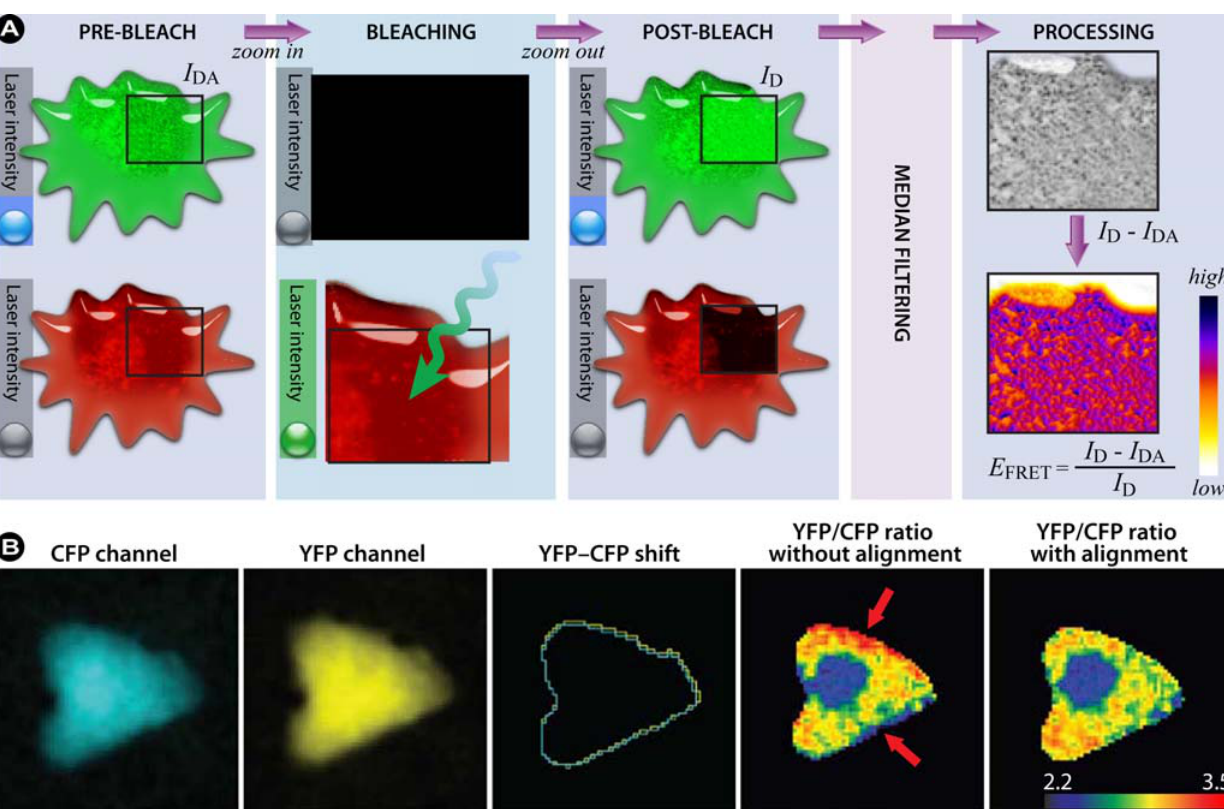
Figure 22. ( A ) Workflow of acceptor photobleaching FRET. ( B ) Ratio imaging artifacts. Shown is an artifact resulting from the ratio calculation of misaligned CFP and YFP